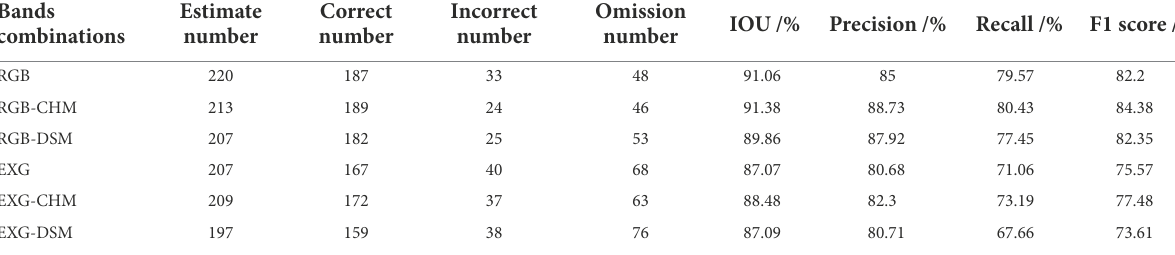
TABLE 3 The accuracy of individual tree-crown detection using different combinations. Bands